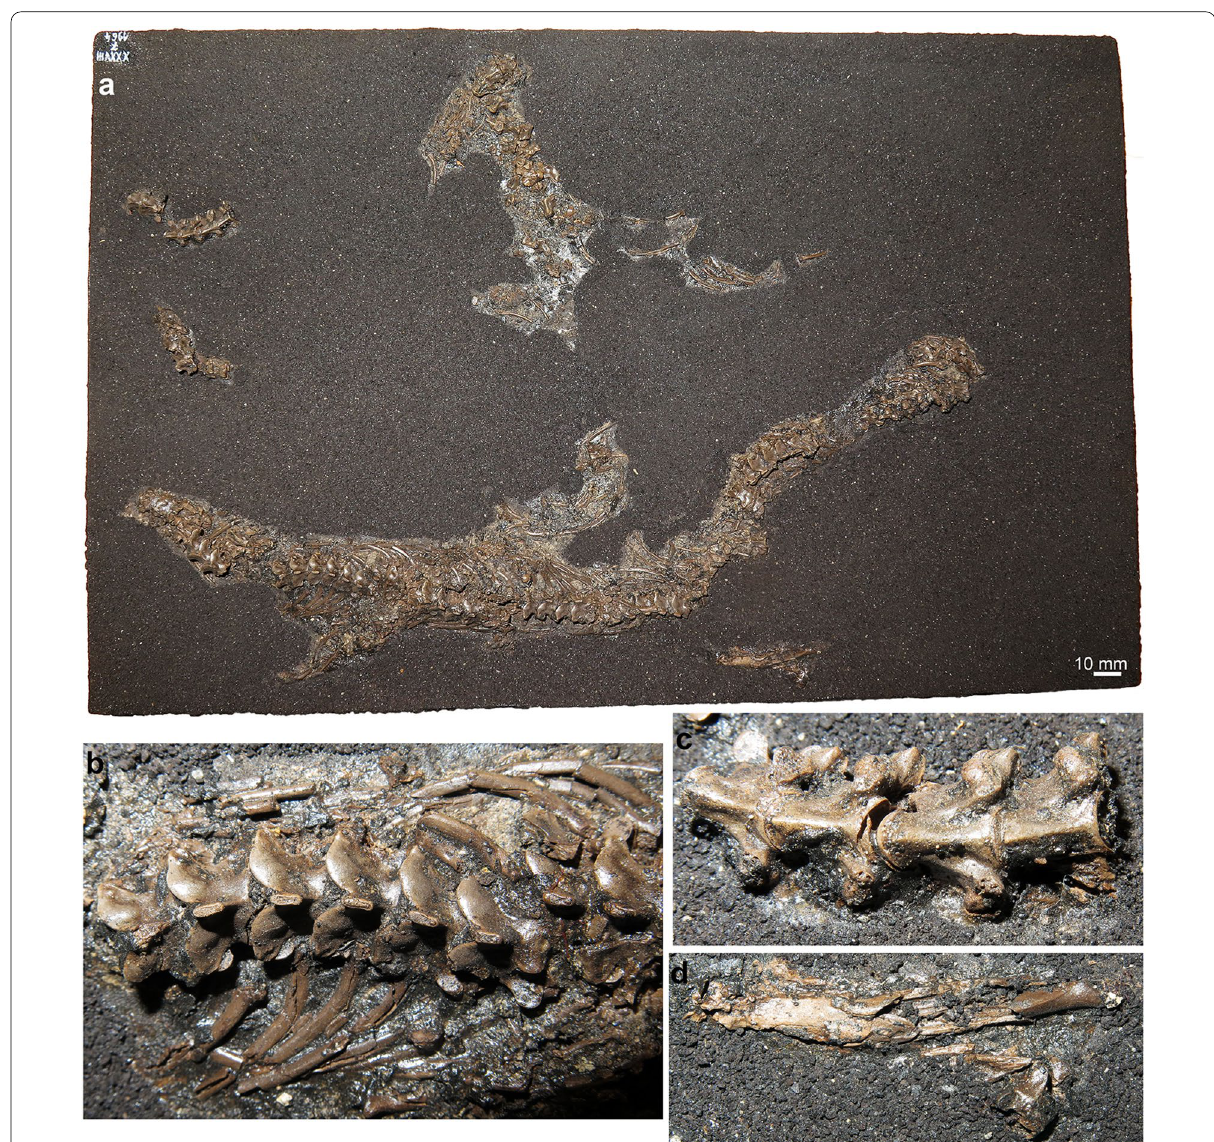
Fig. 64 Eoconstrictor cf. fischeri from quarry XXXVIII, Geiseltal: a several articulated and disarticulated vertebrae and fragments of a skull on a matrix (GMH XXXVIII-7-1964); b – d close ups of the same specimen: b articulated vertebrae in dorsal view and remains of ribs; c articulated vertebrae in ventral view; d fragments of skull. Close up photographs not to the same